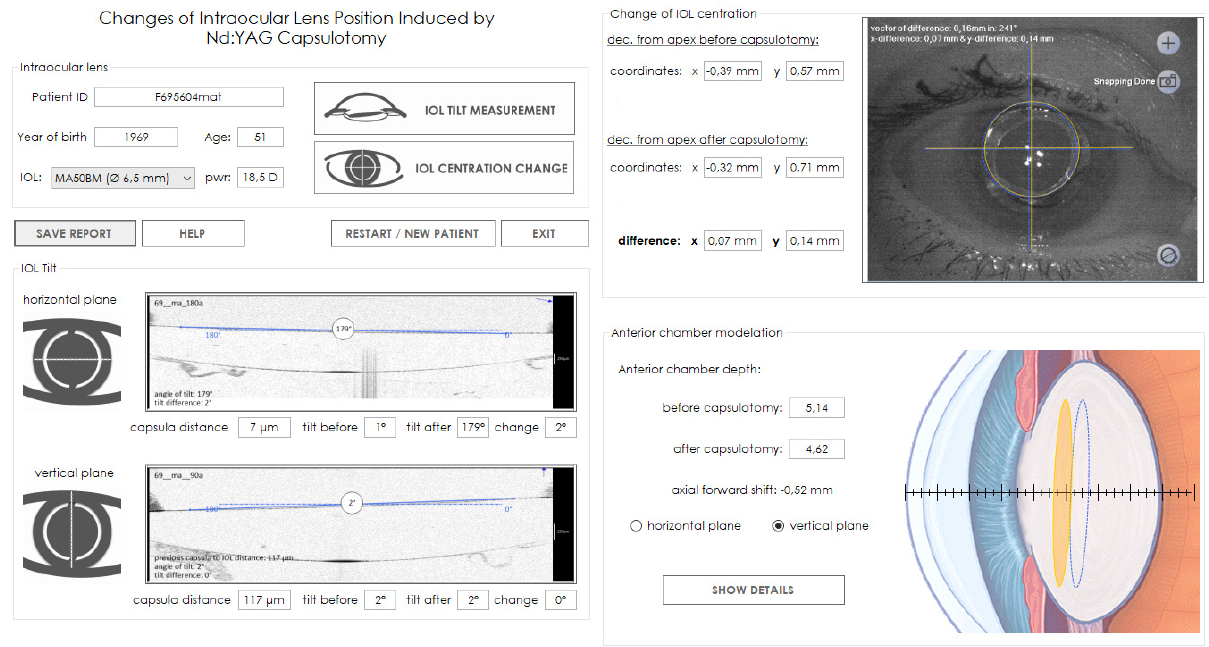
Fig. 4. Final report and graphical visualization of all changes in IOL